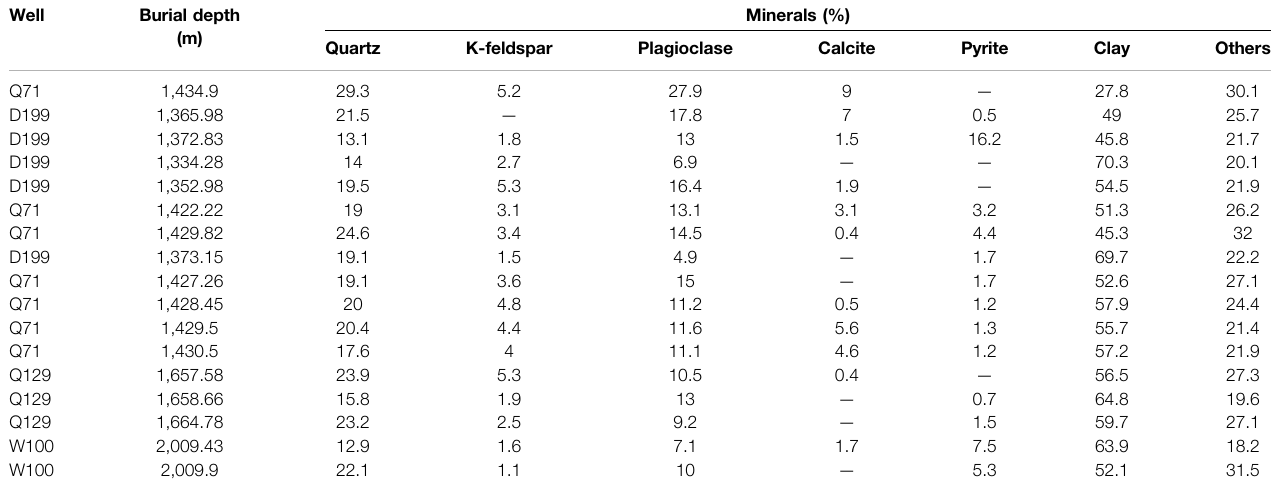
TABLE 1 | Mineral compositions of Chang-7 shale. Well Burial depth